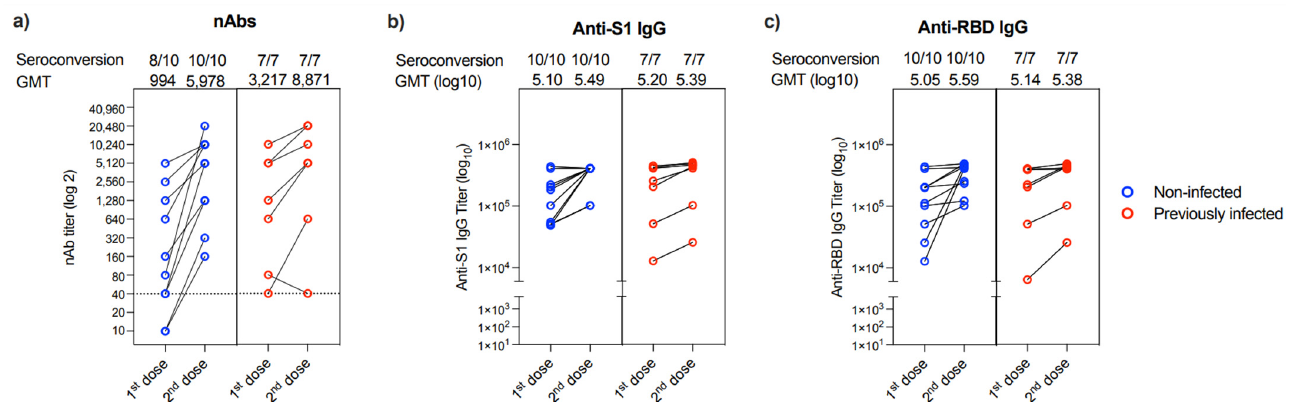
Figure 3. Changes in antibody response in people provided two samples. Changes in ( a ) nAb titers, ( b ) anti-S1 binding IgG end-point titer, and ( c ) anti-RBD binding IgG end-point titer between 1st and 2nd doses in non-infected ( n = 10) or previously infected ( n = 7) individuals who provided two samples after vaccination. Data are reported as geometric mean titer ± standard deviation. Numbers of seroconverted individuals and mean titers are shown on the top of the panels. The dotted line in a is the cut-off at 1:40.